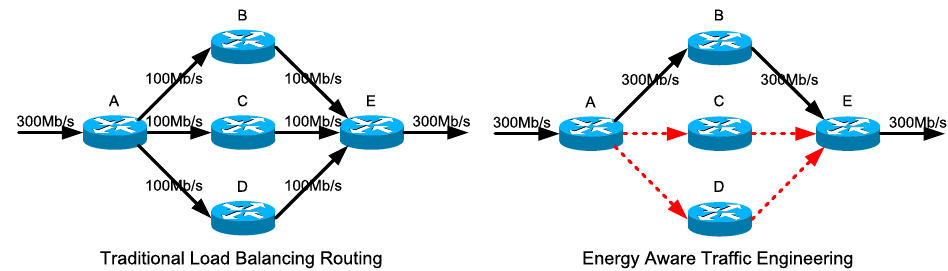
Figure 17. Difference between traditional load balancing routing and energy-aware traffic engineering.